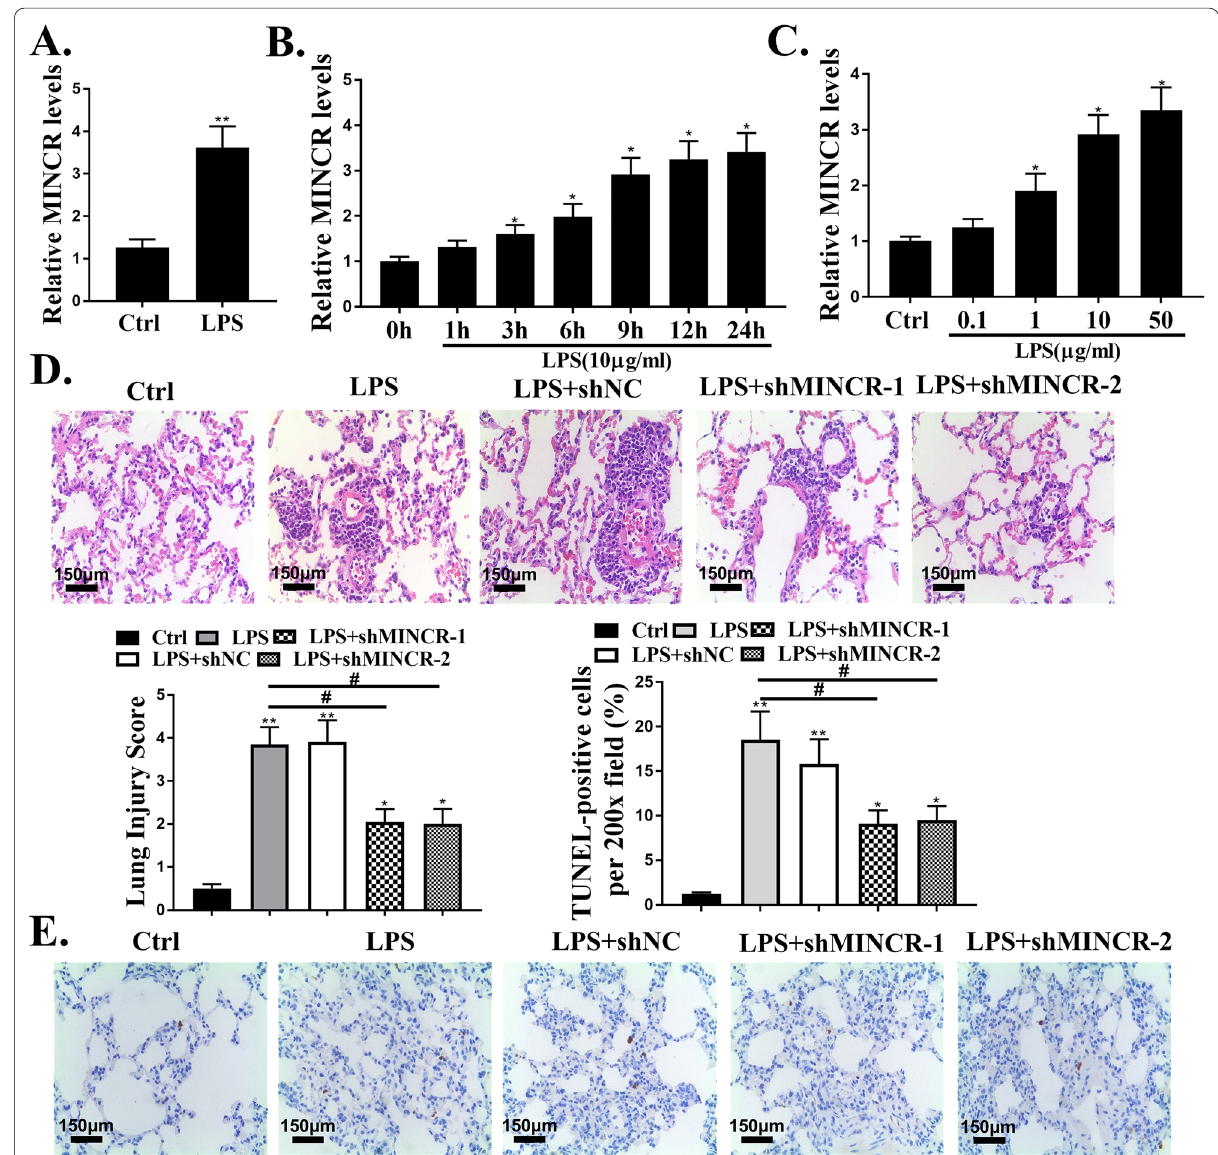
Fig. 1 MINCR was upregulated in acute lung injury (ALI) mouse model and lipopolysaccharide (LPS)-injured alveolar epithelial cells. A the expression levels of MINCR in sepsis-induced ALI models. N 10. B small airway epithelial cells (SAECs) were treated with different doses of LPS for = 12 h, and then the expression level of MINCR was analyzed (N 3). C after exposure to LPS for a specified period of time, the expression level of = MINCR in SAECs was analyzed (N 5). D hematoxylin and eosin staining ( 200) was used to observe the histological changes. Scale bar = × E terminal deoxynucleotidyl transferase biotin-dUTP nick end labeling staining was used to observe the histological changes ( bar 50 μm. * p < 0.05, ** p < 0.01, *** p < 0.001 vs. Ctrl group; # p < 0.05 vs LPS. N = =